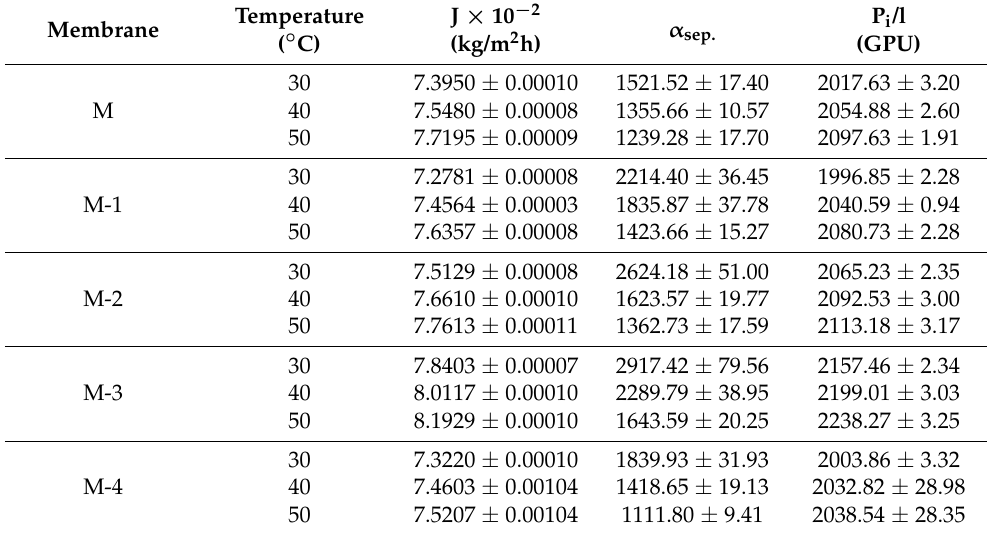
Table 6. Pervaporation flux and separation selectivity of all the membranes at different temperatures.